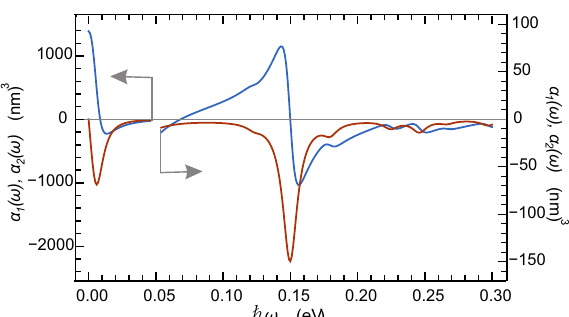
Figure 12. Blue line: in-phase component, α 1 ( ω ) , and red line: quadrature component, α 2 ( ω ) , of polarizability in nm 3 for model 1, versus photon energy, ¯ h ω . Notice the two scales, on left y axis for ¯ h ω < 0.05 eV and on right y axis for ¯ h ω > 0.05 eV.